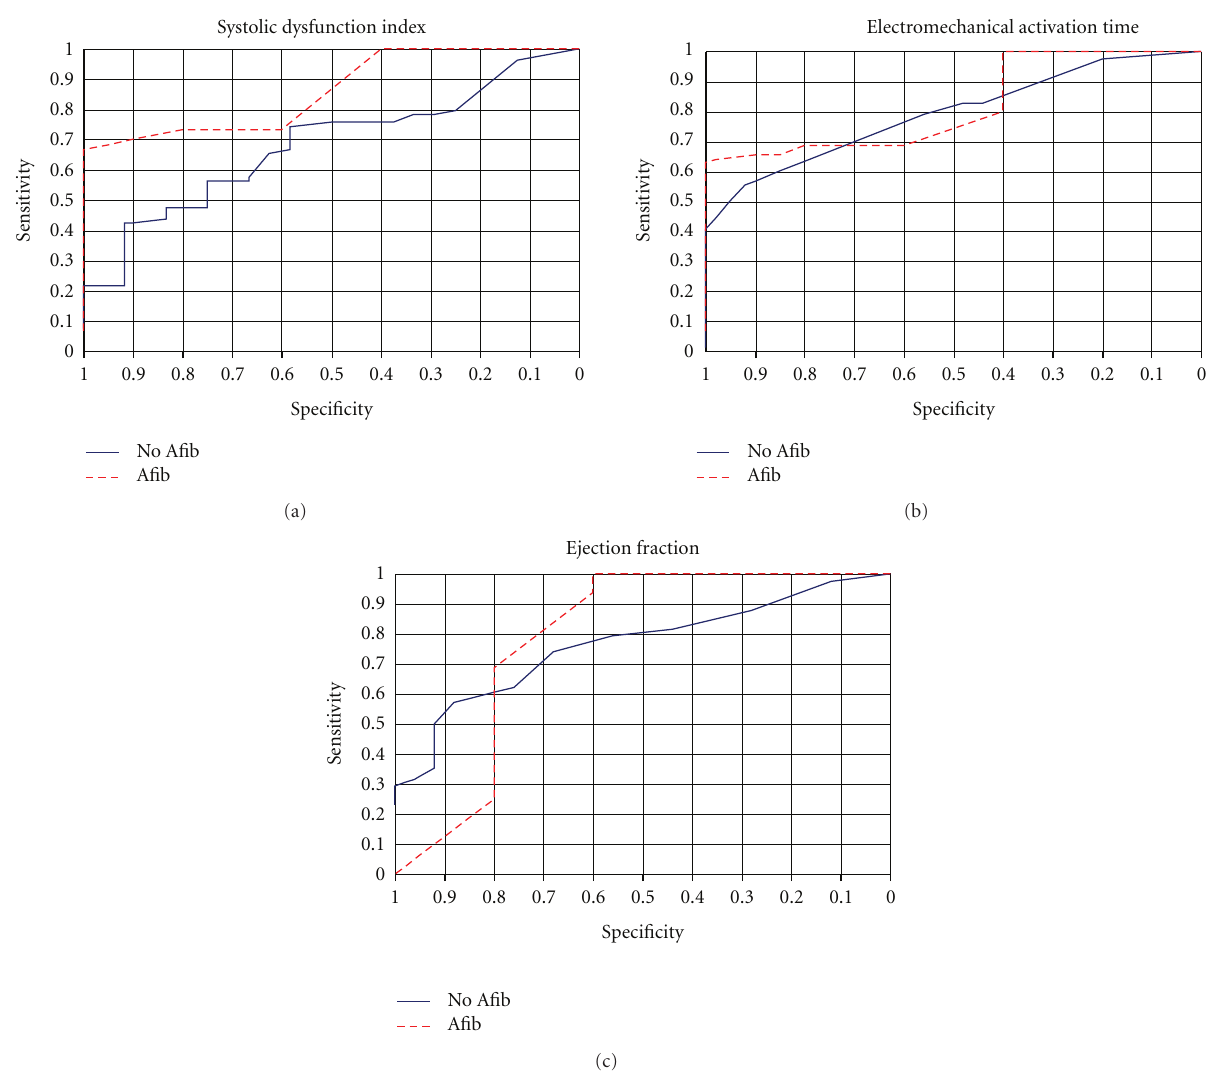
Figure 2: Receiver-operating characteristic (ROC) curves are presented for electromechanical activation time, the systolic dysfunction index and ejection fraction for populations with (red curve) and without atrial fibrillation (blue curve). Afib: atrial